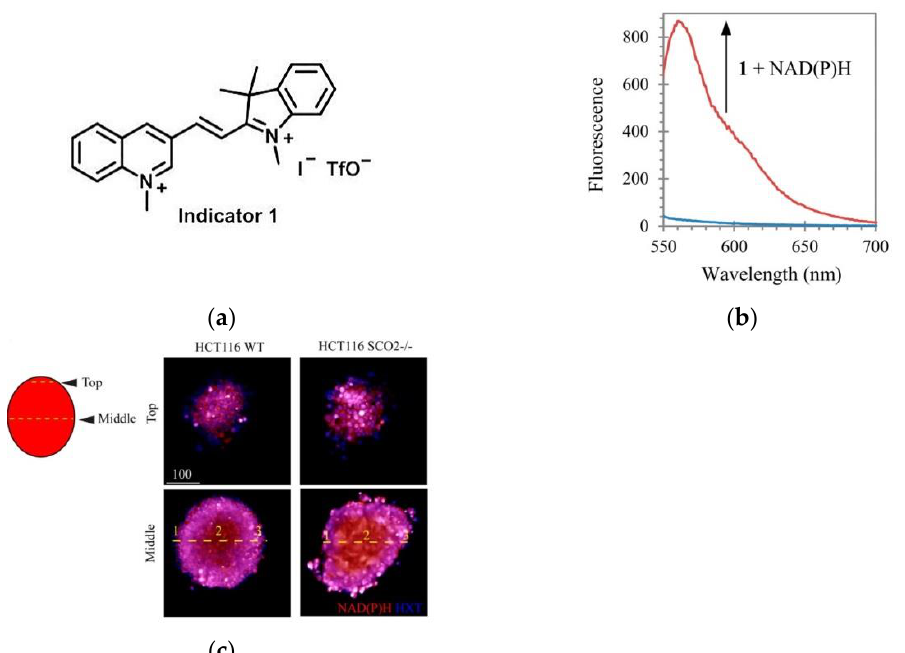
Figure 38. ( a ) The structure of indicator 1; ( b ) Fluorescence spectra of indicator 1; ( c ) Staining of NAD(P)H with indicator 1 in 3D spheroid culture of HCT116 cells. Reproduced with permission from [168]. Copyright 2016 American Chemical Society.